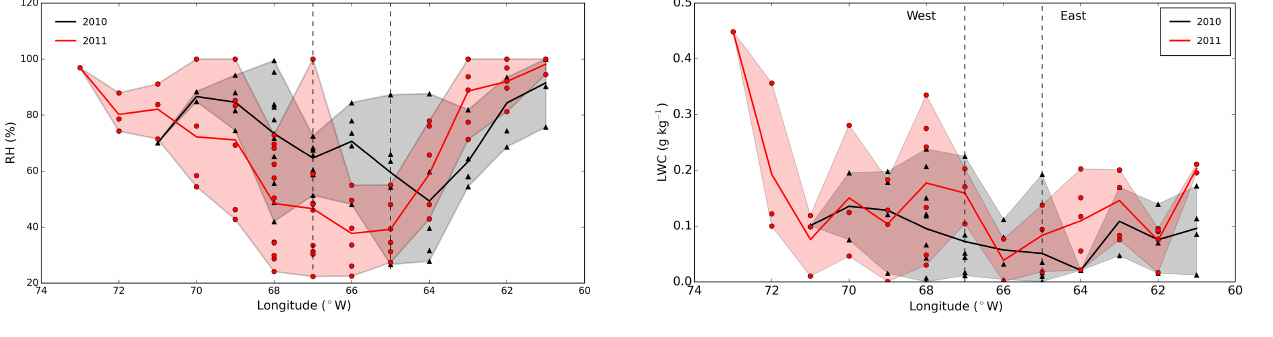
Figure 7. Same as Fig. 4 but for the liquid water content (LWC, gkg − 1 ).